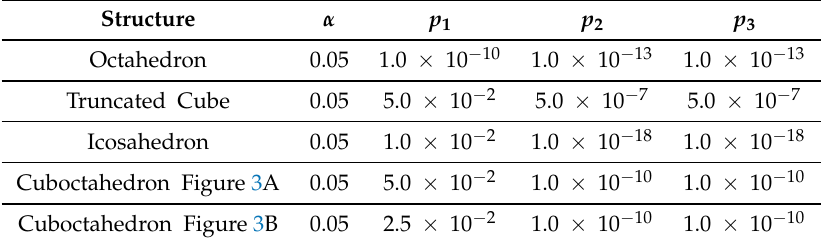
Table 6. Shape parameters for the platinum turnover frequency (TOF) via the Langmuir–Hinshelwood (L–H) mechanism.